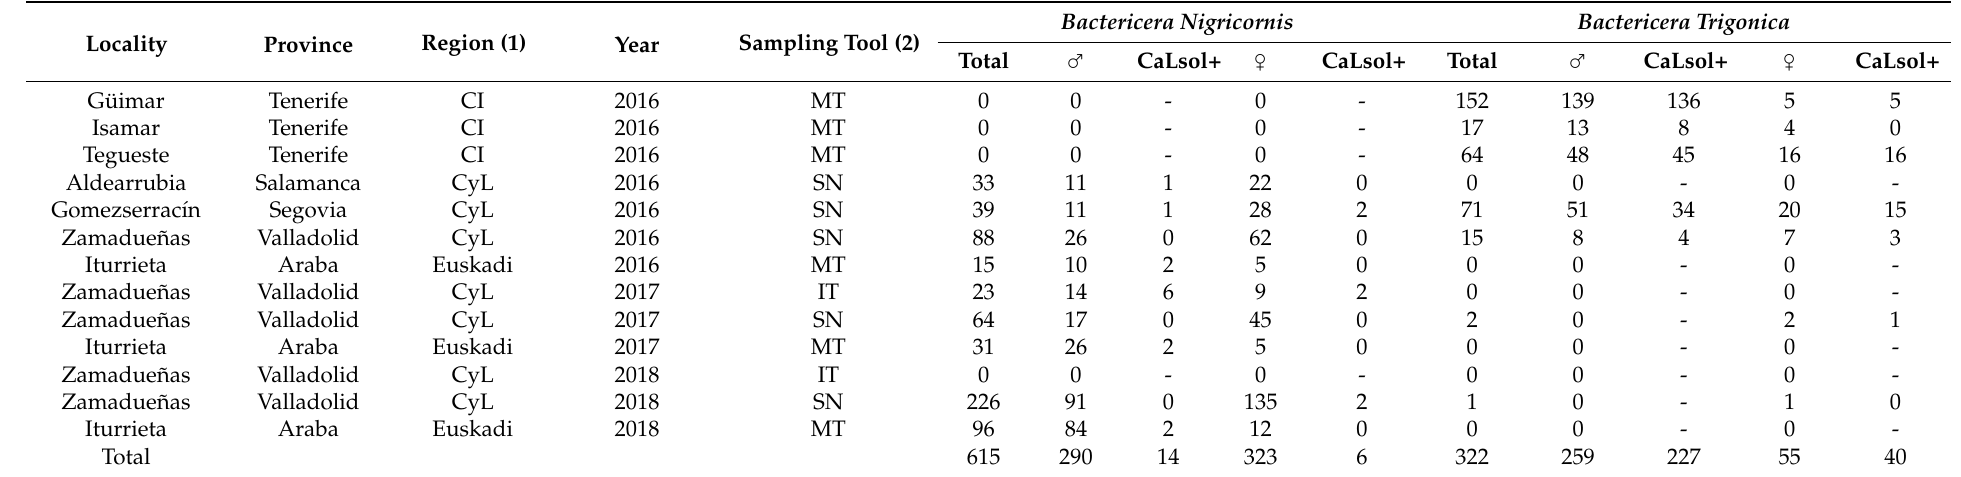
Table 2. Number of psyllids by sampling tool, identified by species and gender, and CaLsol detecTable 2016, 2017, and 2018.